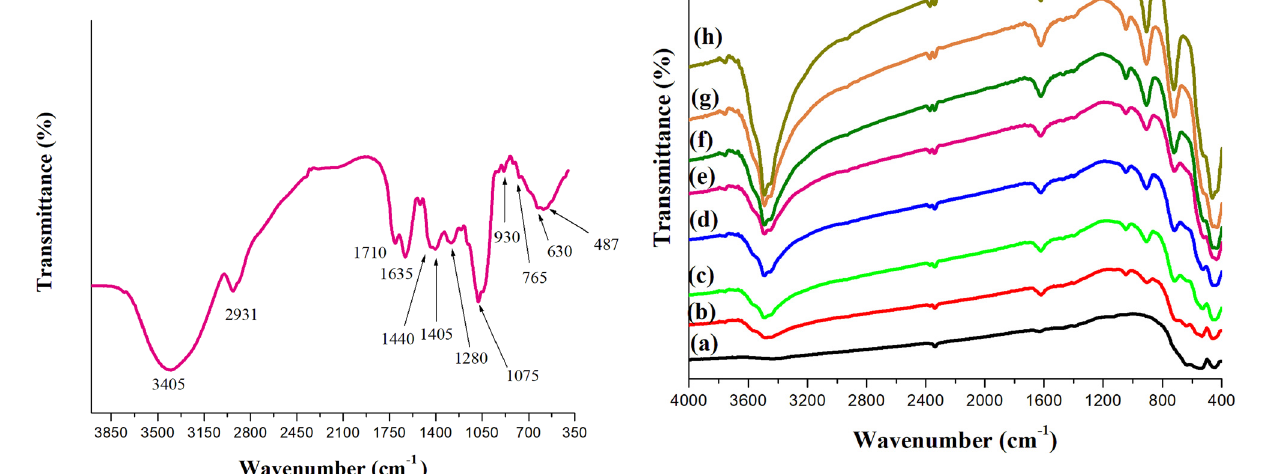
Figure 1: FTIR spectrum of WOLE.